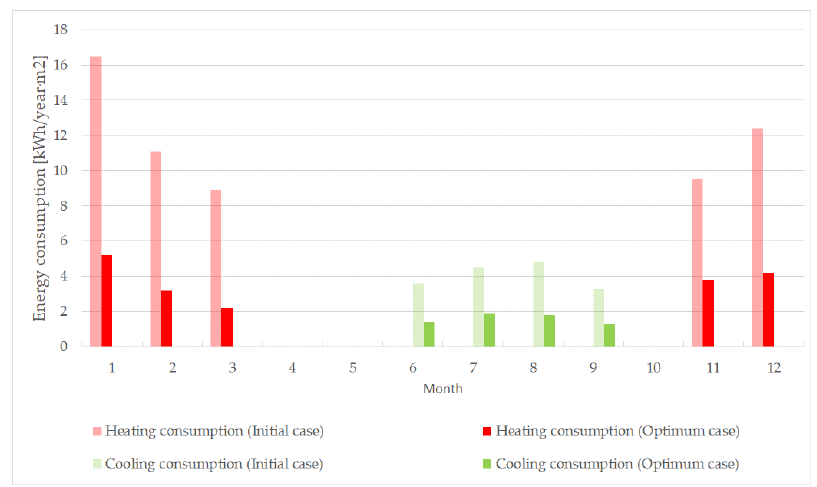
Figure 13. Comparison of estimated energy consumption—initial situation vs. optimum scenario